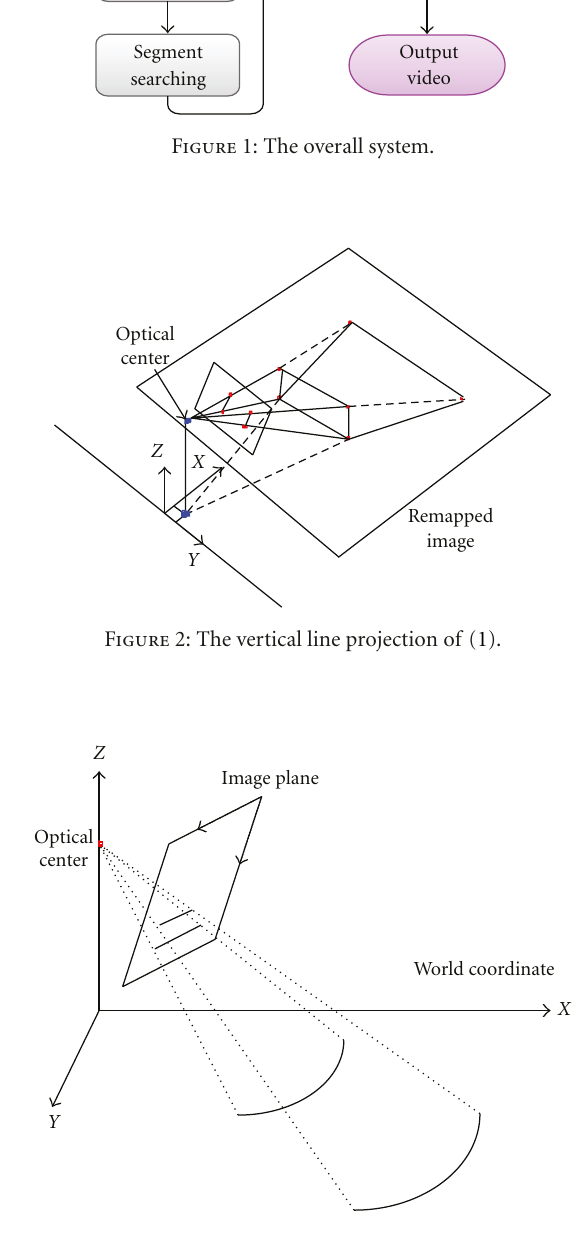
Figure 3: The projected results of